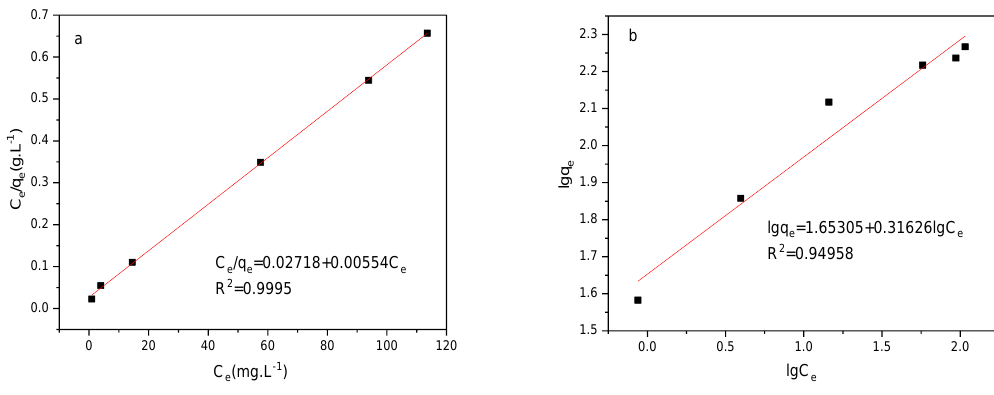
Figure 7. ( a ) Langmuir and ( b ) Freundlich isotherm models.